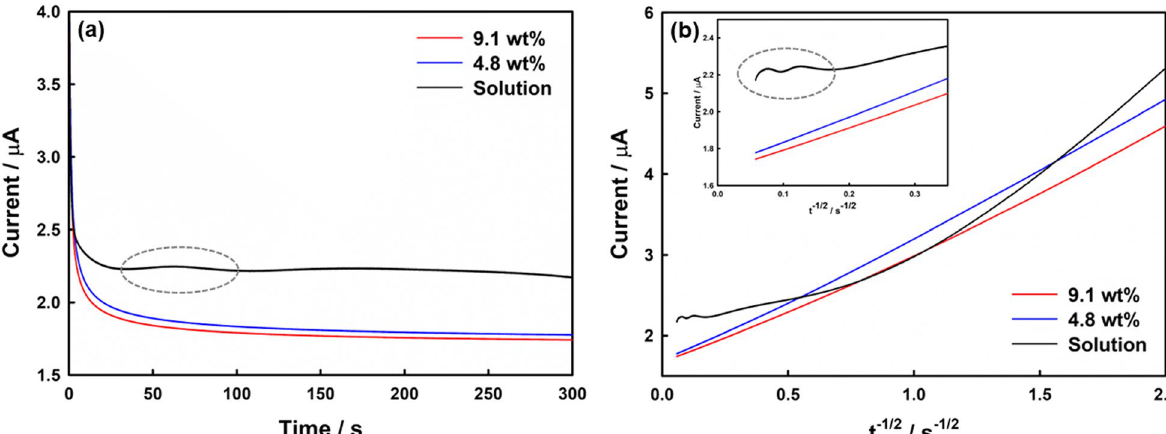
Fig. 4 a CA curves of 1 mM Fe(CN) 64– and 0.1 M KCl in various agarose hydrogel concentrations (colored lines) and in solution (black line) at an applied potential of 0.3 V using a Au disk electrode. b Plots of current as a function of the t –1/2 of ( a ) and highlighted long‑term domain (inset). The gray dotted circle showed the current fluctuations due to the natural